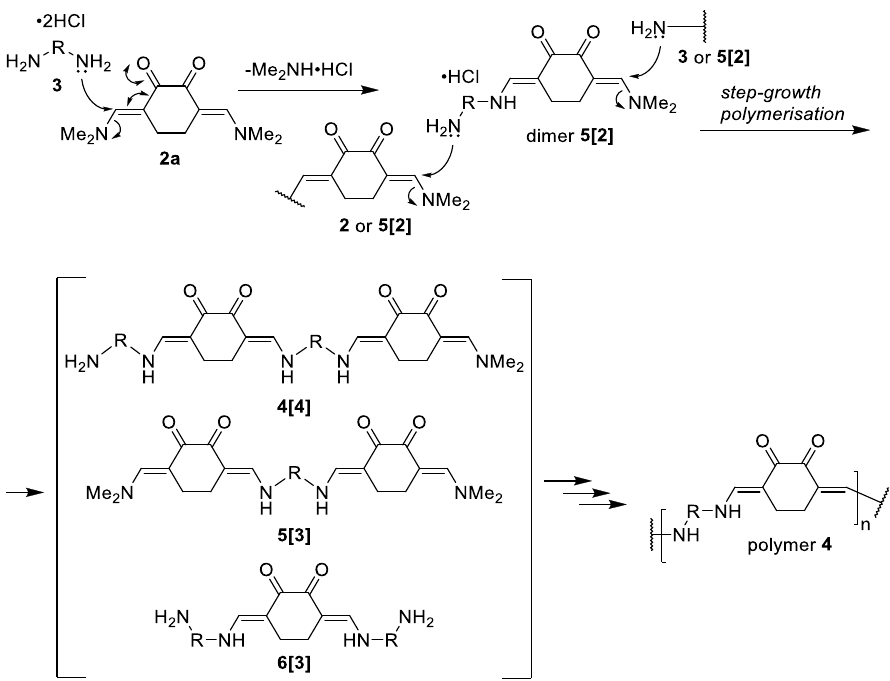
Table 1. Experimental data for compounds 4